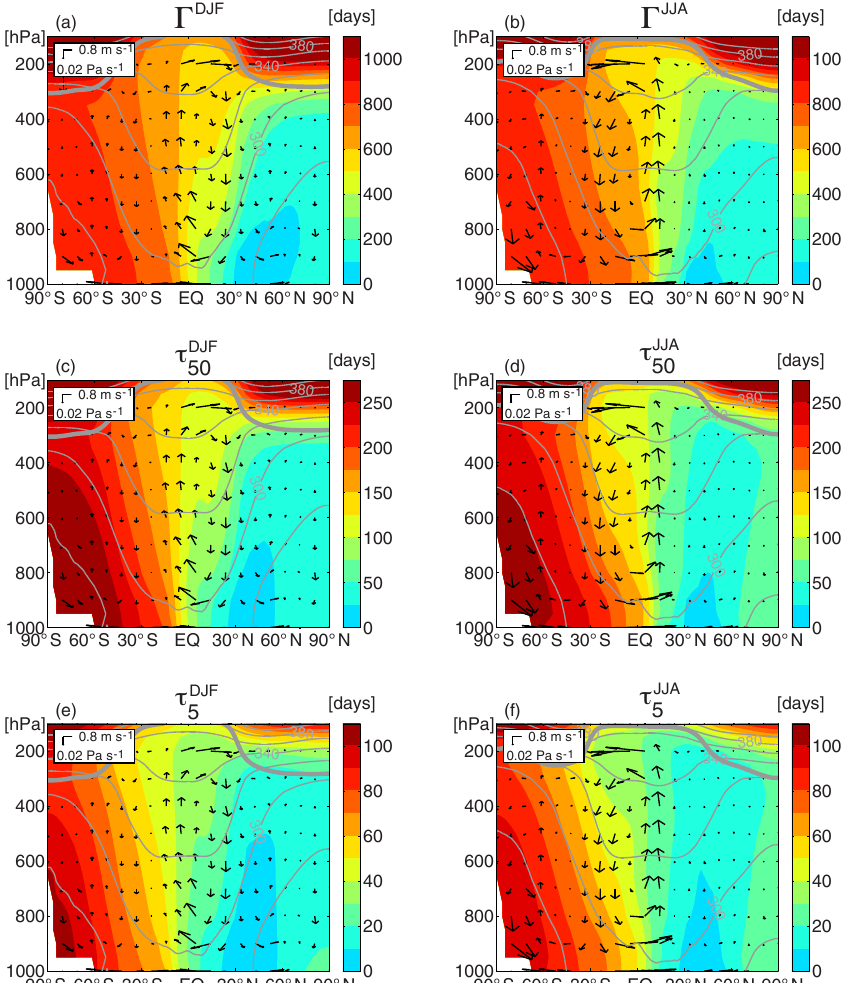
Figure 1. Latitude–pressure distribution of the climatological seasonal-mean zonal-mean (a, b) (cid:48) , (c, d) τ 50 , and (e, f) τ 5 , for boreal winter (DJF) and boreal summer (JJA). Arrows show the meridional circulation, thin contours show isentropes (contours every 20K), and the thick contour shows the